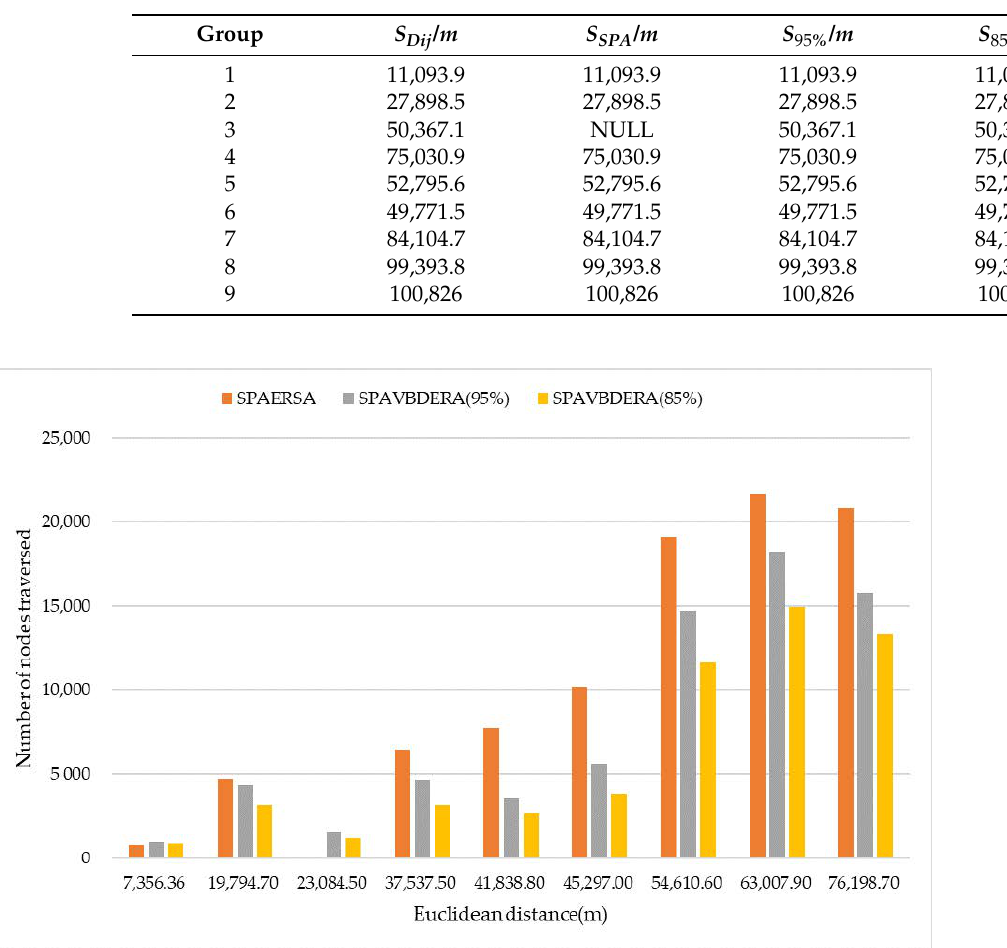
Figure 10. Three algorithms running time under different Euclidean distance. From Table 2, the optimal path solution obtained by SPAVBDERA proposed in this paper is always reliable, because the shortest path obtained by SPAVBDERA and Dijkstra